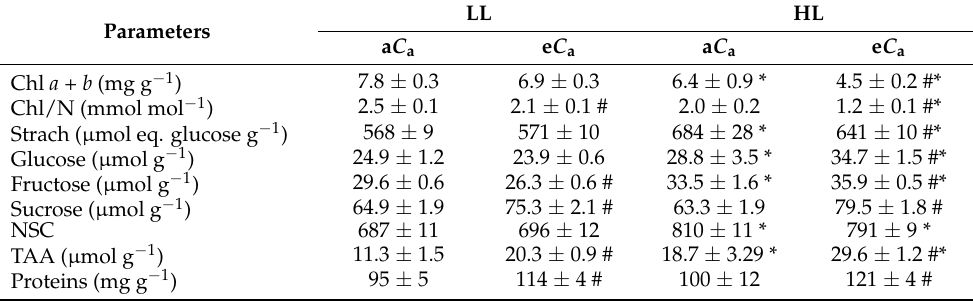
Table 2. The effect of light intensity [low (LL) or high (HL) light] and CO 2 supply [ambient (a C a ) or elevated (e C a )] on foliar pigments and metabolites (on a dry weight basis) of coffee plants: total chlorophylls (Chl a + b ), starch, glucose, fructose, sucrose, nonstructural carbohydrates (NSC), total amino acids (TAA), and proteins. The Chl/N ratio is also presented. When shown, asterisk (*) indicates differences between light regimes within the same CO 2 supply, whereas hash (#) indicates differences between CO 2 treatments within the same light regime ( p ≤ 0.05, t test, n = 6 ± SE). LL HL Parameters a C a e C a a C a e C a Chl a + b (mg g − 1 ) 7.8 ± 0.3 6.9 ± 0.3 6.4 ± 0.9 * 4.5 ± 0.2 #* Chl/N (mmol mol − 1 ) 2.5 ± 0.1 2.1 ± 0.1 # 2.0 ± 0.2 1.2 ± 0.1 #* Strach ( µ mol eq. glucose g − 1 ) 568 ± 9 571 ± 10 684 ± 28 * 641 ± 10 #* Glucose ( µ mol g − 1 ) 24.9 ± 1.2 23.9 ± 0.6 28.8 ± 3.5 * 34.7 ± 1.5 #* Fructose ( µ mol g − 1 ) 29.6 ± 0.6 26.3 ± 0.6 # 33.5 ± 1.6 * 35.9 ± 0.5 #* Sucrose ( µ mol g − 1 ) 64.9 ± 1.9 75.3 ± 2.1 # 63.3 ± 1.9 79.5 ± 1.8 # NSC 687 ± 11 696 ± 12 810 ± 11 * 791 ± 9 * TAA ( µ mol g − 1 ) 11.3 ± 1.5 20.3 ± 0.9 # 18.7 ± 3.29 * 29.6 ± 1.2 #* Proteins (mg g − 1 ) 95 ± 5 114 ± 4 # 100 ± 12 121 ± 4 #